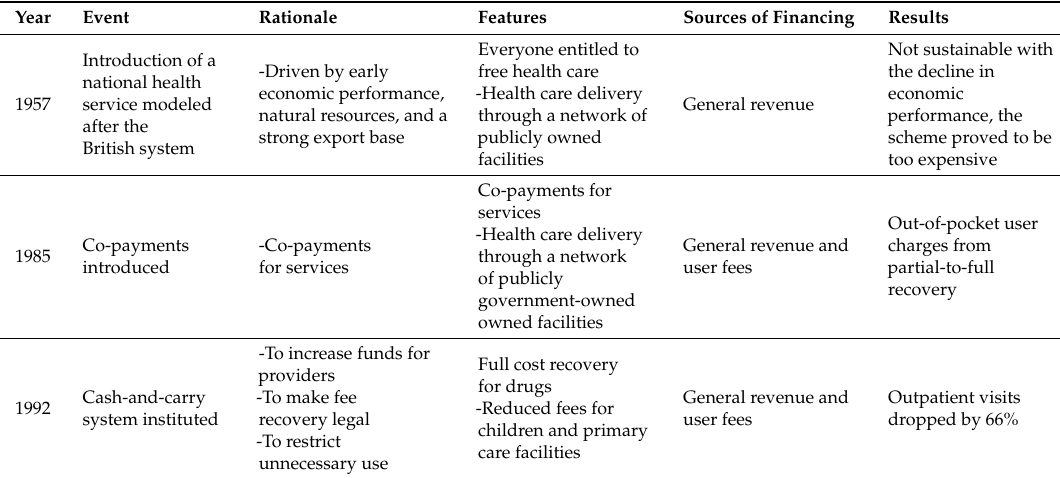
Table 1. Chronological Development of Health Care Financing in